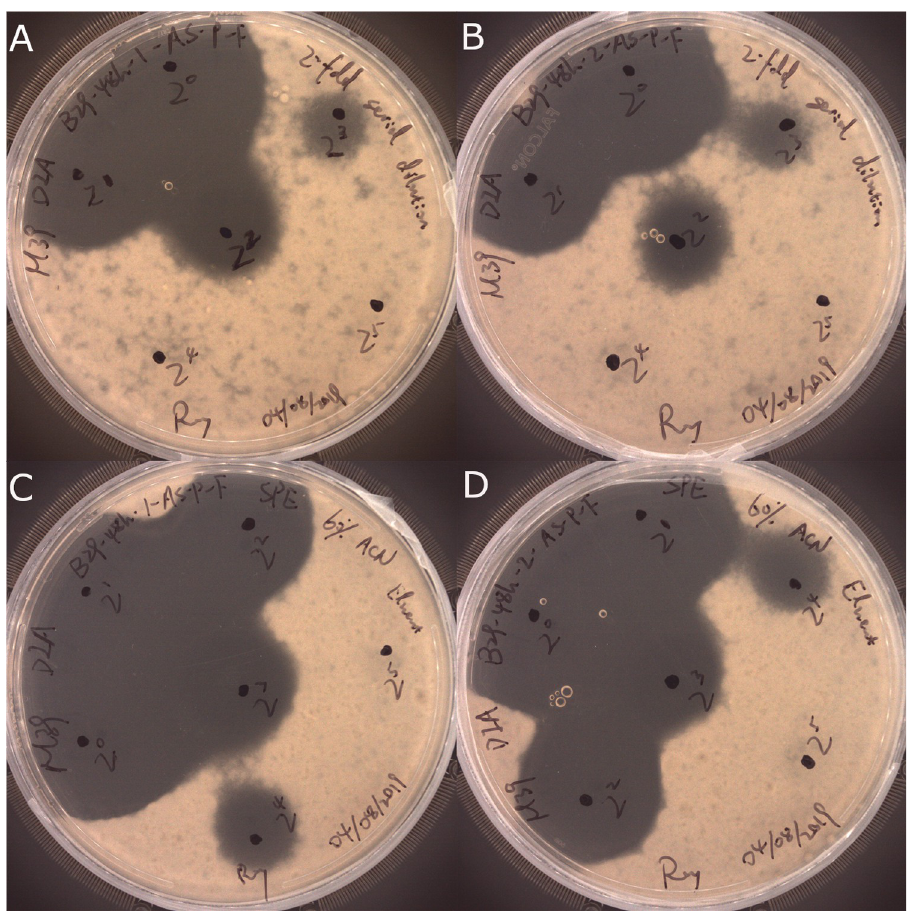
Fig 1. Deferred inhibition assay of purified products from Bacillus velezensis WRB-ZX-001 and WRB-ZX-002 against food-isolated Aspergillus fumigatus . Precipitates of WRB-ZX-001 and WRB-ZX-002 from 60% ammonium sulfate were shown in A and B. Solid phase extraction eluates of 60% acetonitrile for WRB-ZX-001 and WRB-ZX-002 were shown in C and D. Two-fold serial dilution was performed for all samples to determine the antifungal activity